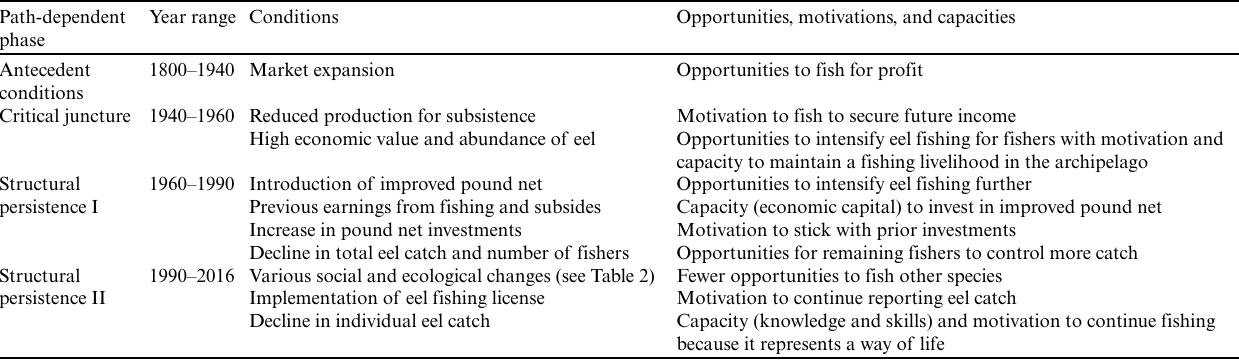
Table 1. Overview of the entrapment process in the Kalmar pound net fishery, describing the origin and persistence of dependence on the eel to maintain a fishing livelihood. The opportunities, motivations, and capacities explain how eel fishing continued in response to changes in social and ecological